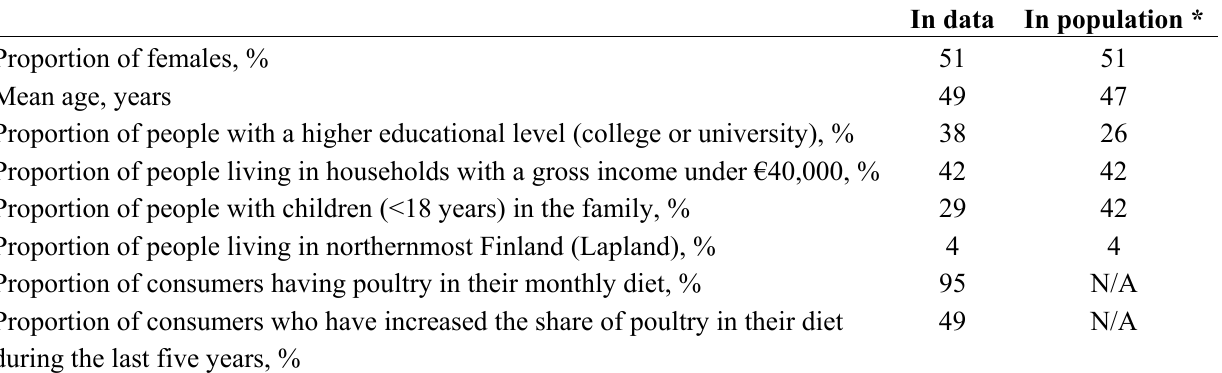
Table 1. Descriptive statistics for the respondents in the data set and the 18- to 79-year-old population in